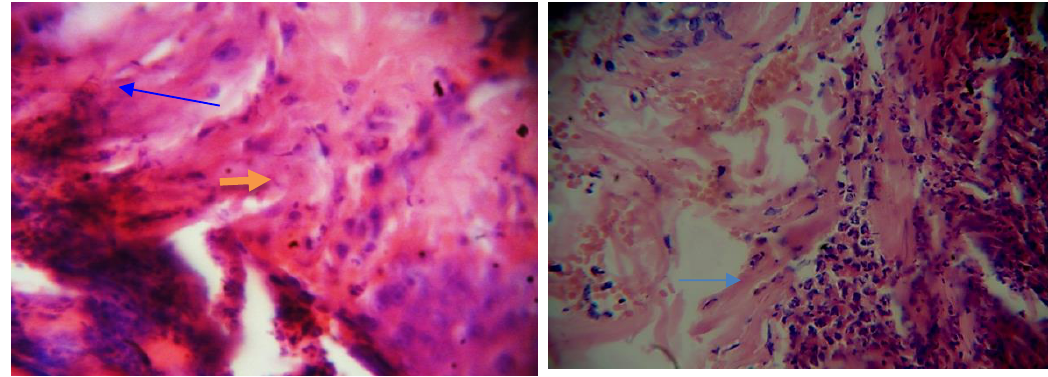
Figure, 4: Shows that inflammatory cells infiltration with necrosis extended to the muscle layers , 5 days post operation in control group (H&E 40X).